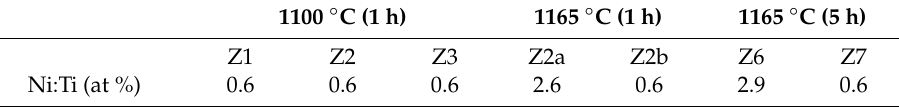
Table 5. Ni:Ti after sintering (Figure 10).